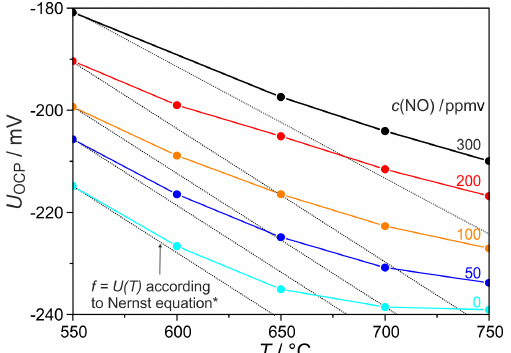
Figure 3. Dependence of the cell voltage at open circuit potential ( U OCP ) on the sensor temperature T at different NO concentrations. Flow rate = 10sccm; c (O 2 ) = 0 . 2ppmv. ∗ U OCP curves at constant p (O 2 ) in the sample gas at T = 550 ◦